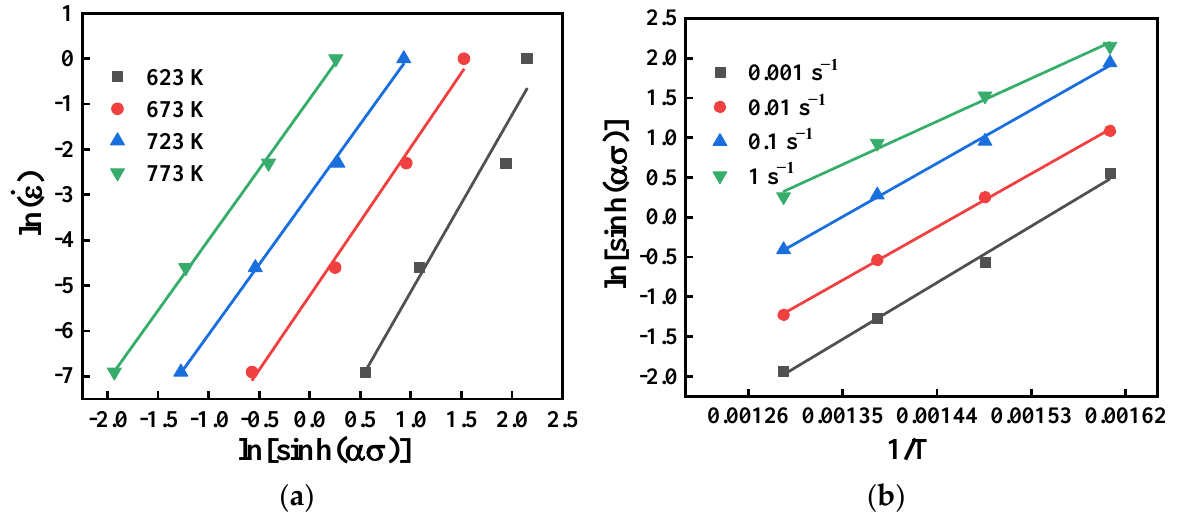
Figure 5. Relationship between: ( a ) ln𝜀̇ and ln[𝑠𝑖𝑛ℎ(𝛼𝜎)] ; ( b ) ln[𝑠𝑖𝑛ℎ(𝛼𝜎)] and 1/𝑇 .